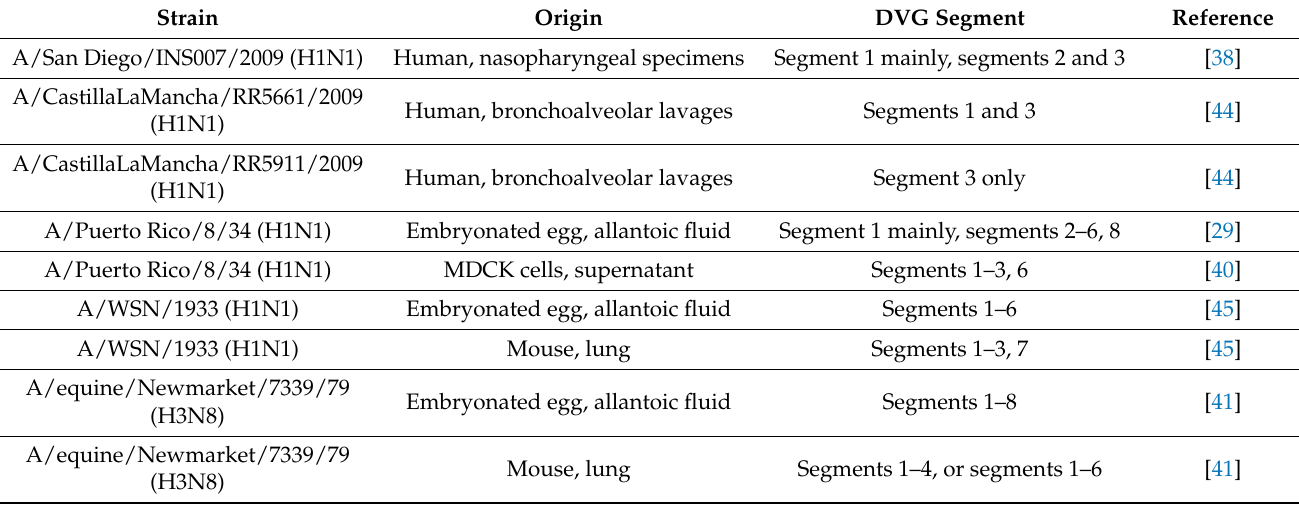
Table 1. Previously reported defective viral genome segments in different influenza virus A strains from different